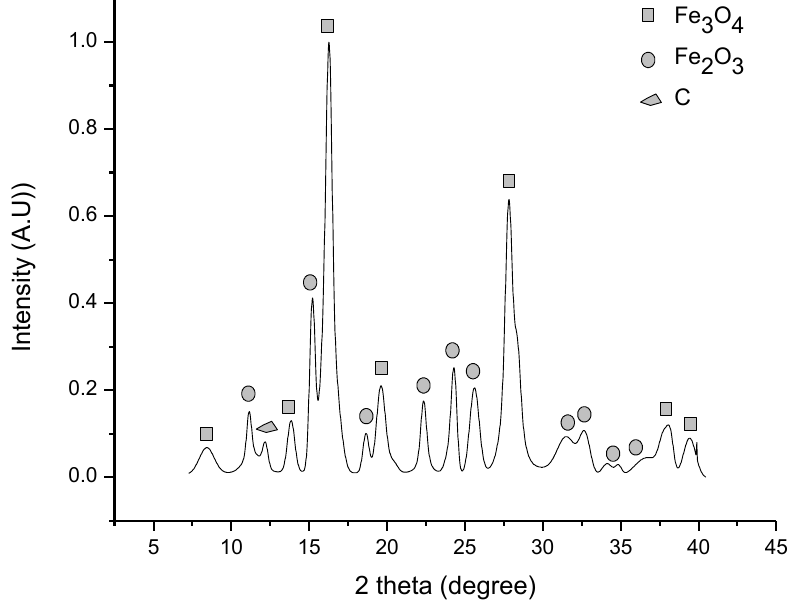
Figure 7. XRD pattern after siderite decomposition at 300 °C in a vacuum. Magnetite, hematite, and graphite were identified.